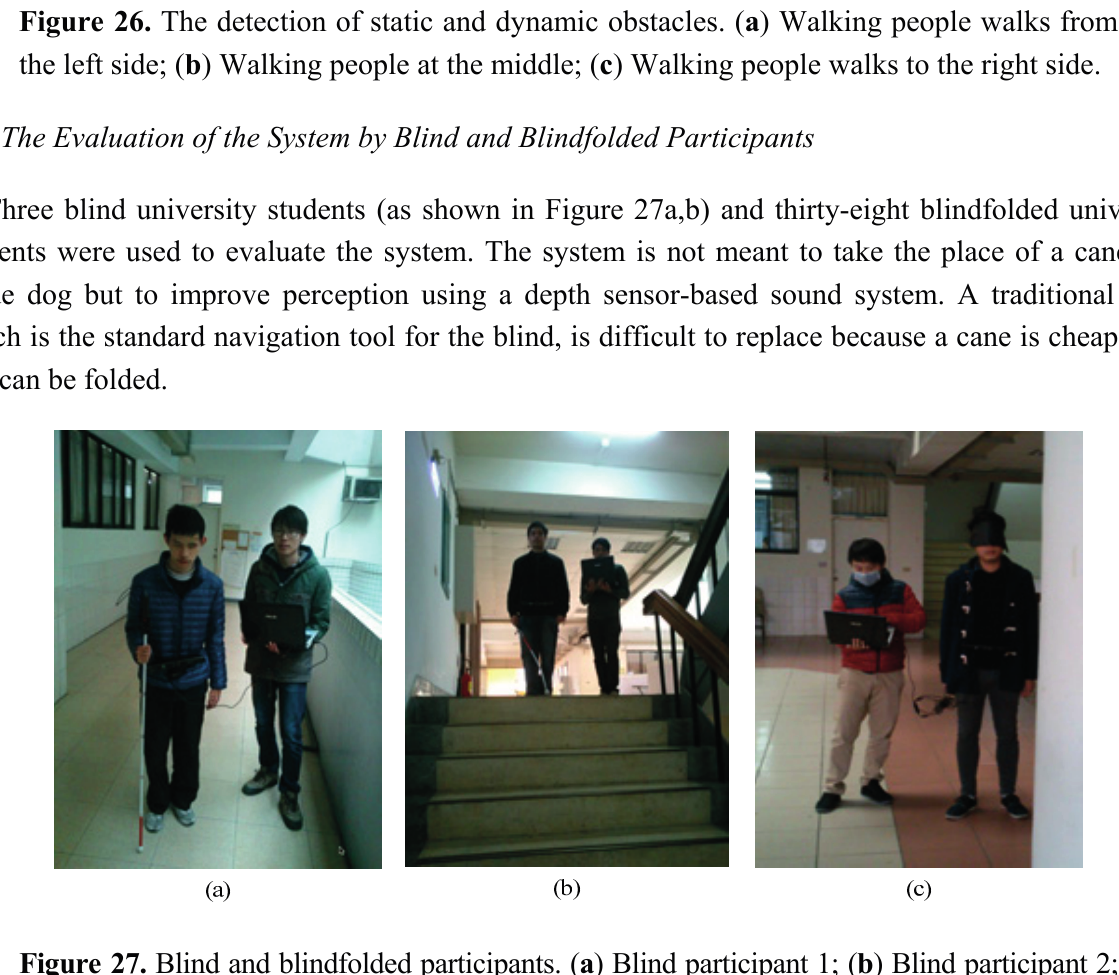
Figure 27. Blind and blindfolded participants. ( a ) Blind participant 1; ( b ) Blind participant 2; ( c ) Blind-folded